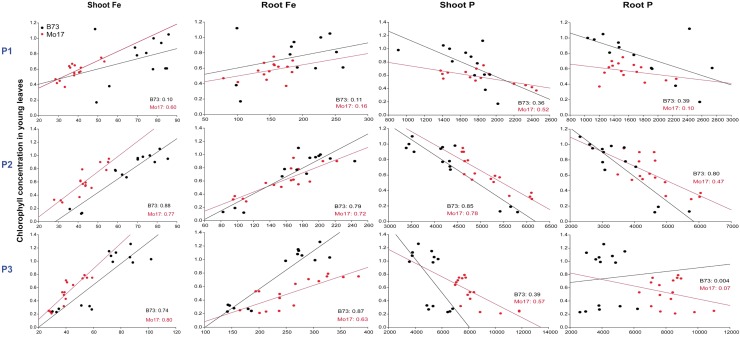
Influence of varied Fe and P nutritional regimes on chlorophyll formation in the maize genotypes B73 and Mo17. Graphs show correlations between chlorophyll (in mg g-1) and Fe or P concentrations (in μg g-1) in shoots or roots of either B73 or Mo17 plants at each P supply level. Coefficients of correlation (r2) are indicated for either genotype within the plots. Plants were grown for 17 days in nutrient solution supplemented with 10, 50, or 200 μM P (P1–P3) and with 10, 30, 70, or 200 μM Fe (F1–F4) in all 12 combinations.